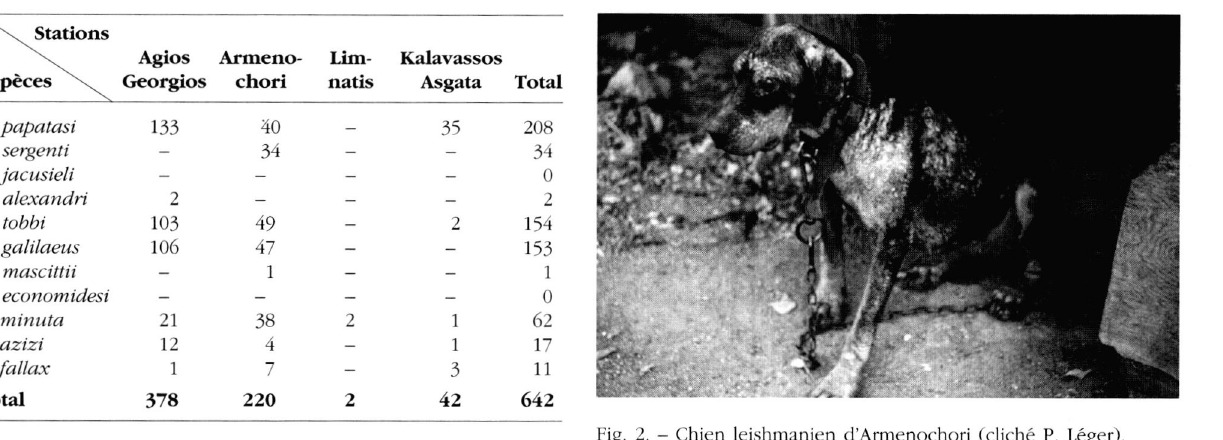
Fig. 2. - Chien leishmanien d'Armenochori (cliché P. Léger). Proche-Orient, sans doute P. syriacus Adler et Theodor, 1931, vecteur suspecté mais non